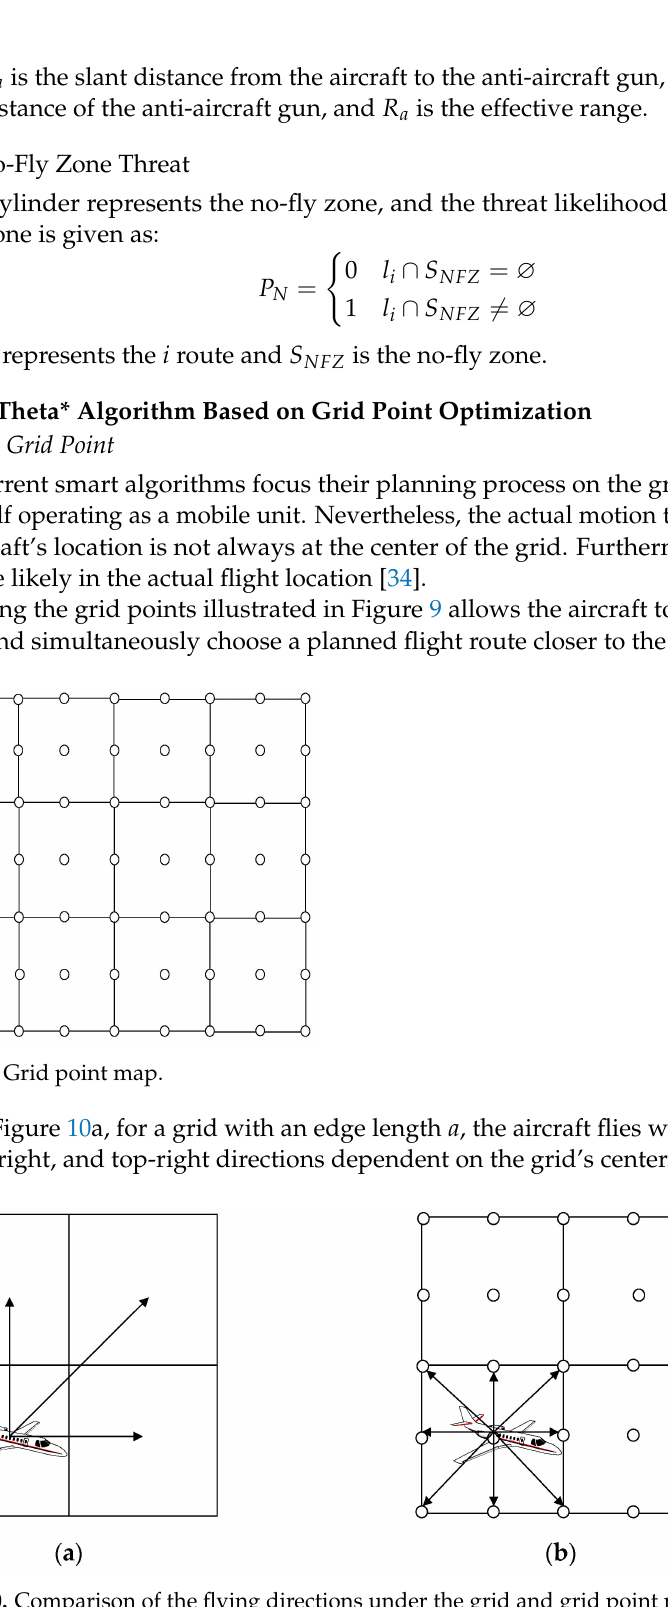
Figure 10. Comparison of the flying directions under the grid and grid point map. ( a ) Grid map and ( b ) Grid point